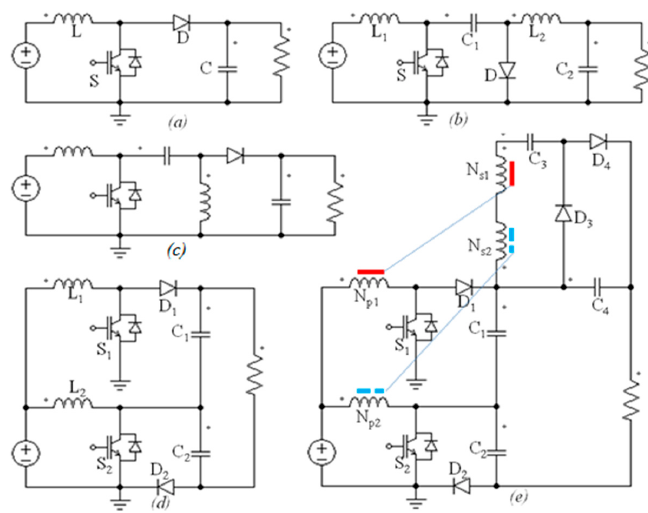
Figure 1. Basic DC-DC converter ( a ), Cuk ( b ), SEPIC ( c ), parallel input ( d ), and parallel input- coupled inductor- voltage multiplier cell ( e ).